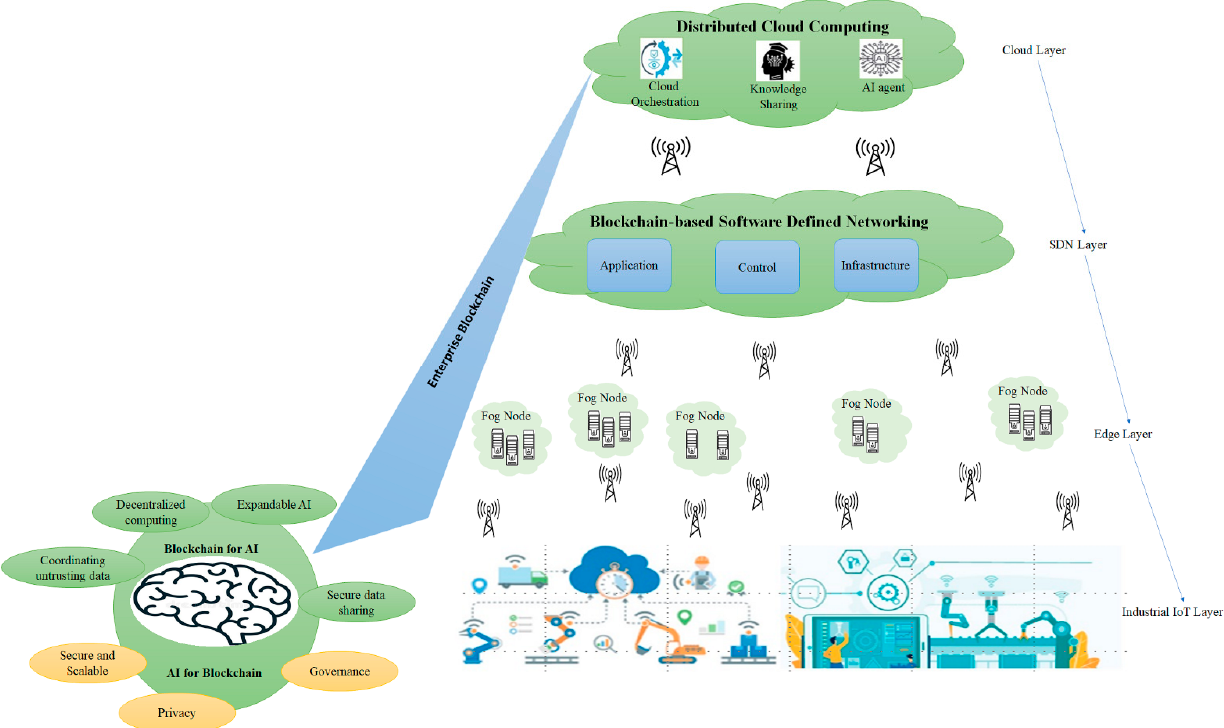
Figure 1. layers and modular-based open logistics architecture. Figure 1. Layers and modular-based open logistics architecture. Table 1. Explanation of each DC